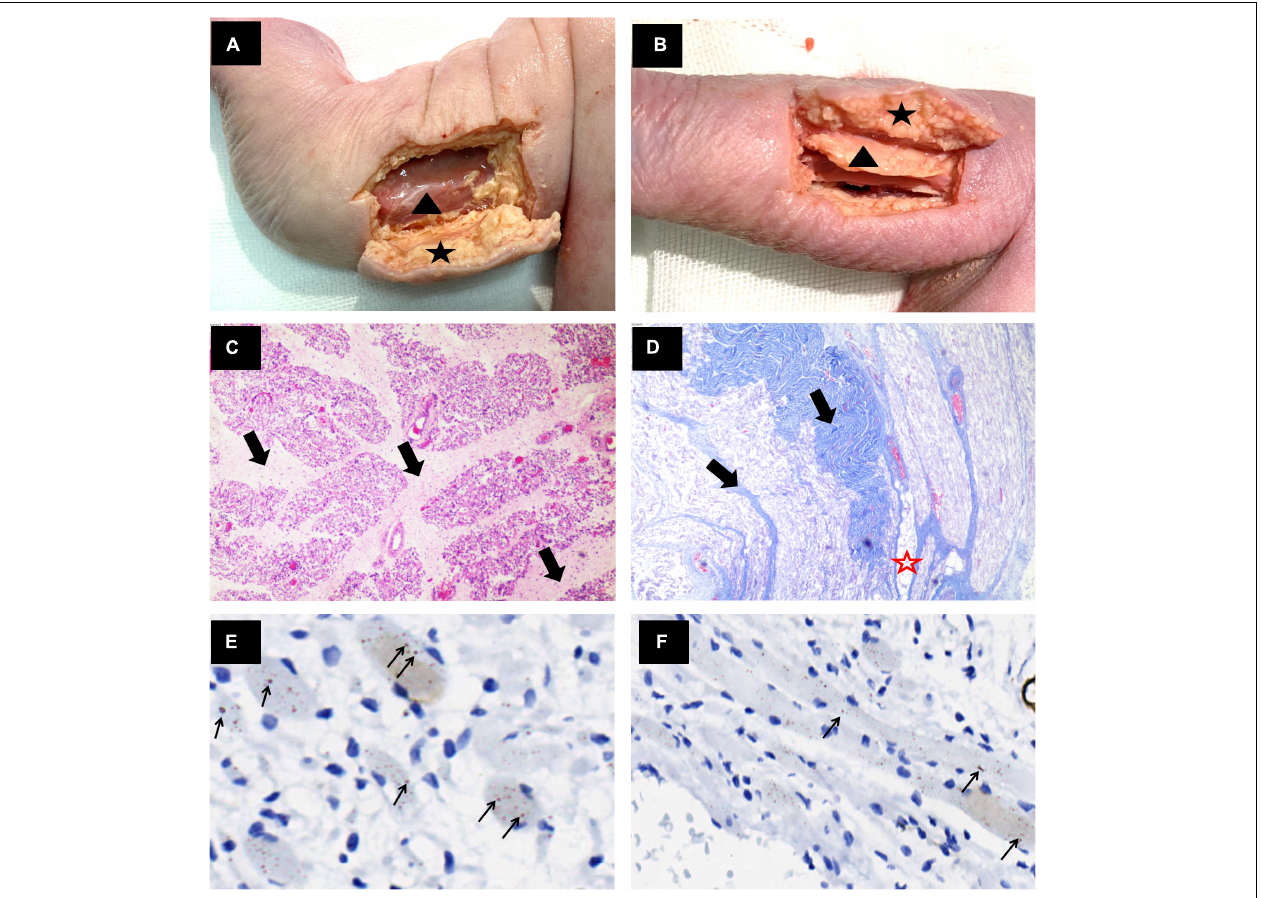
FIGURE 3 | Anatomical and pathological images of the limb muscles. (A,B) Gross anatomy showed thickened subcutaneous fat (black star) and a thin muscle layer (black triangle) in the lower limbs of the fetus. (C) Right thigh muscle cross section H&E × 40 and (D) Right forearm muscle longitudinal section Masson trichrome × 40. The muscle bundles showed marked variation in size, and muscle fibers were replaced by fibrous tissue (thick black arrows) and adipose tissue (red star). (E,F) Right calf muscle cross section and longitudinal section anti- α -actinin antibody stained × 400. The muscle fibers were sparse, degenerated, and atrophied. Lots of nemaline rods in muscle fibers were strongly stained with anti- α -actinin antibody (thin black